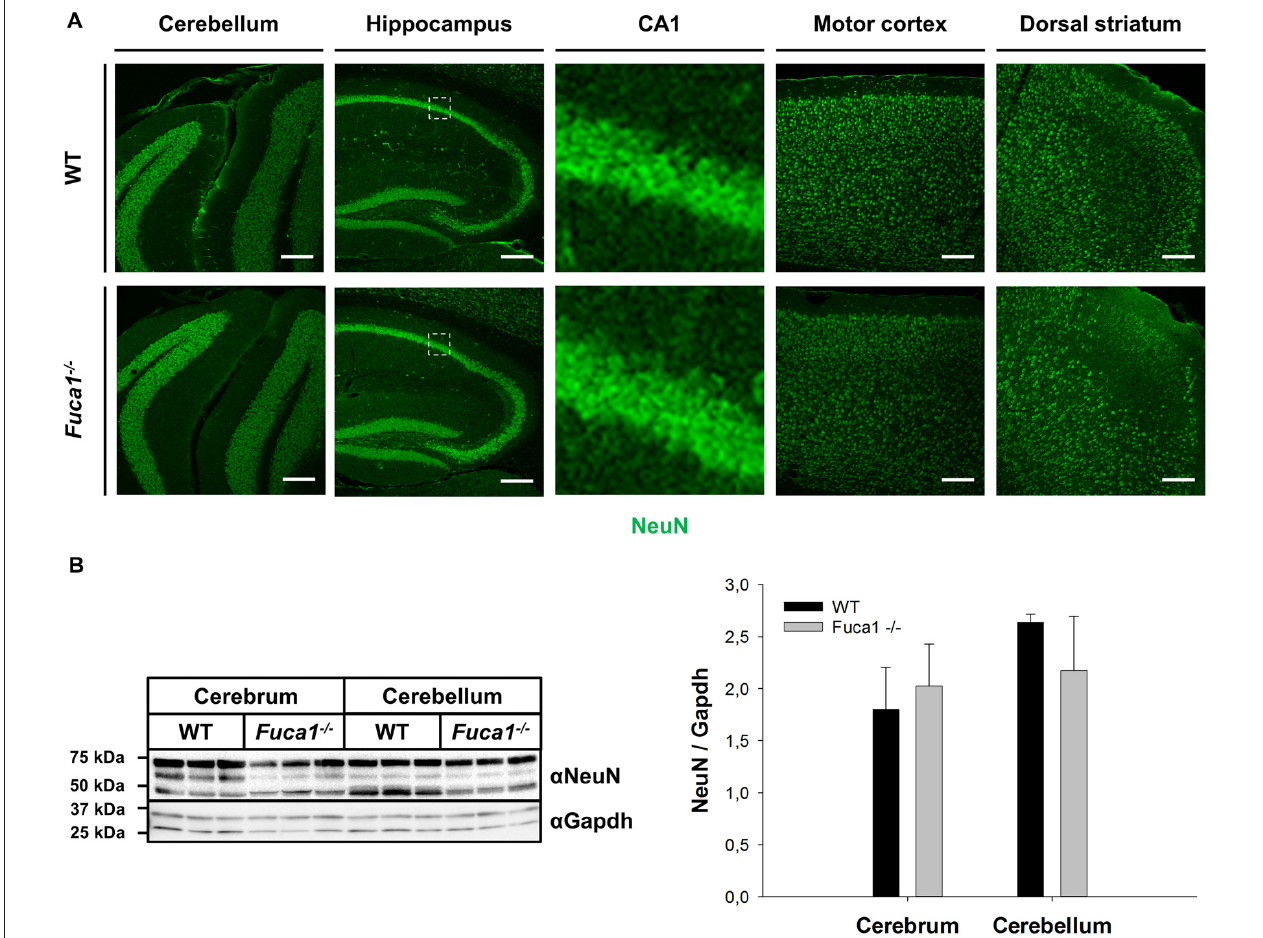
FIGURE 4 | Fuca1-deficient mouse brains show normal levels of NeuN protein. (A) Immunofluorescence staining of brain sections from 3-month-old mice showed no alterations in NeuN protein in the cerebellum, hippocampus, motor cortex and dorsal striatum of Fuca1-deficient animals. Scale bars = 200 µ m. (B) The amount of NeuN protein is unaffected in the Fuca1 gene knock-out as shown by immunoblotting of cerebral and cerebellar tissue homogenates from 3-month-old mice (mean ± SD, n = 3). Gapdh was used for normalization.